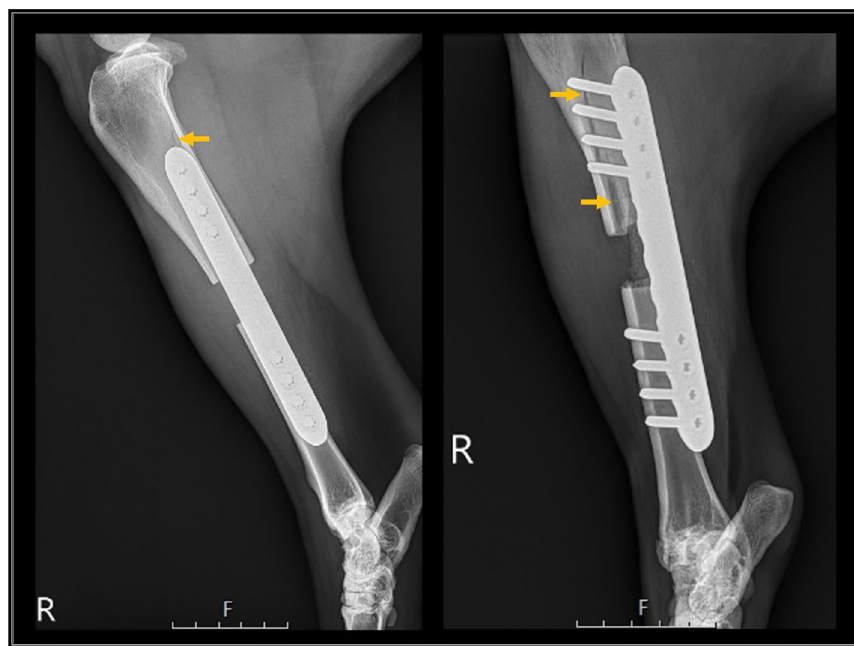
Fig. 5 Lateromedial and caudolateral‑craniomedial oblique radiographic projections of fractured caprine tibia (yellow arrows). These images illustrate the most common fracture configuration, an incomplete, longitudinal oblique fracture of the proximal tibial segment with the fracture line following the screw holes